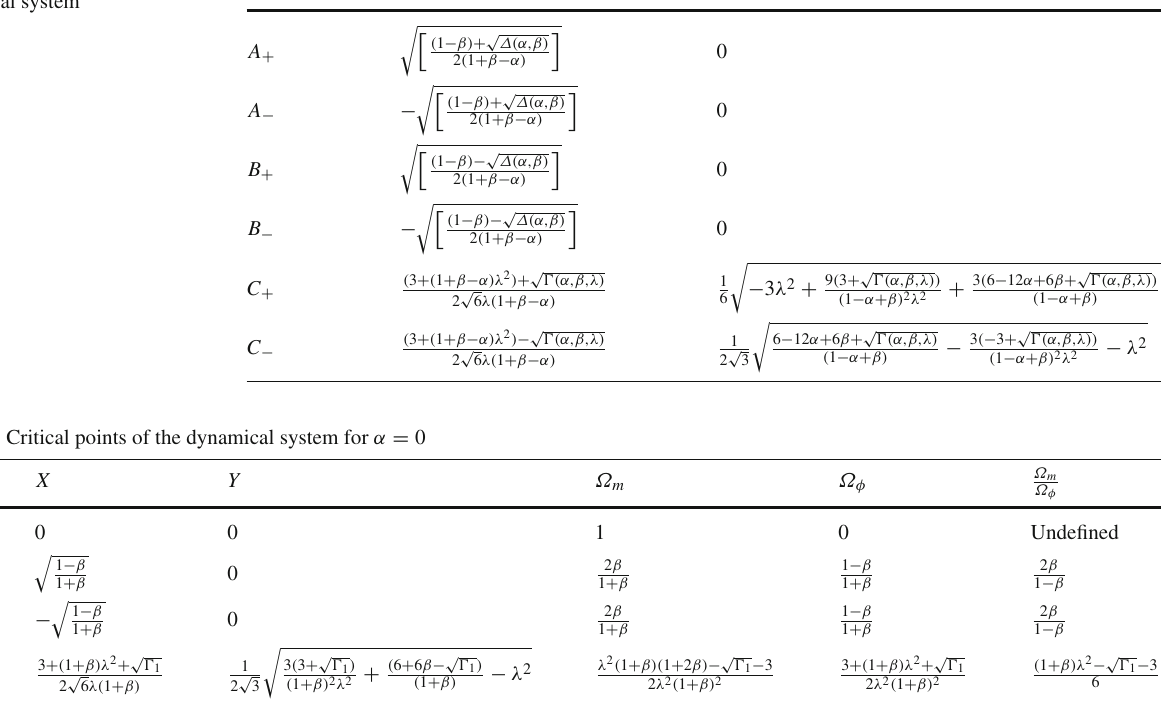
Table 1 Critical points of the dynamical system